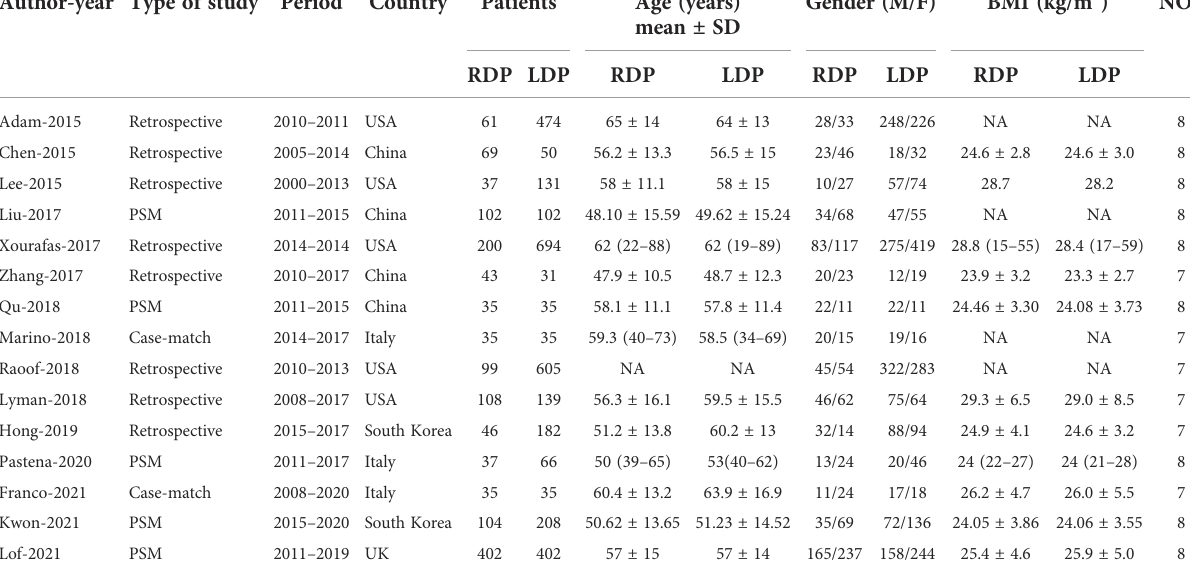
TABLE 1 Characteristics of included